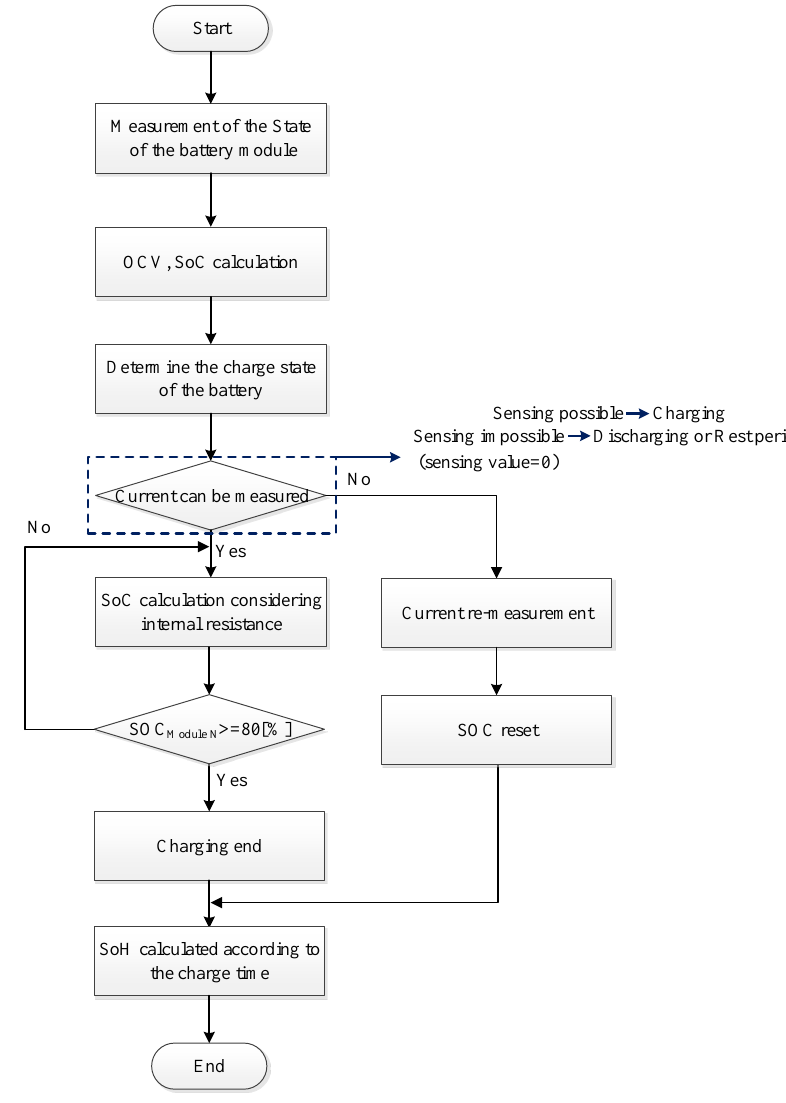
Figure 4. Proposed SoC and SoH calculation algorithm.